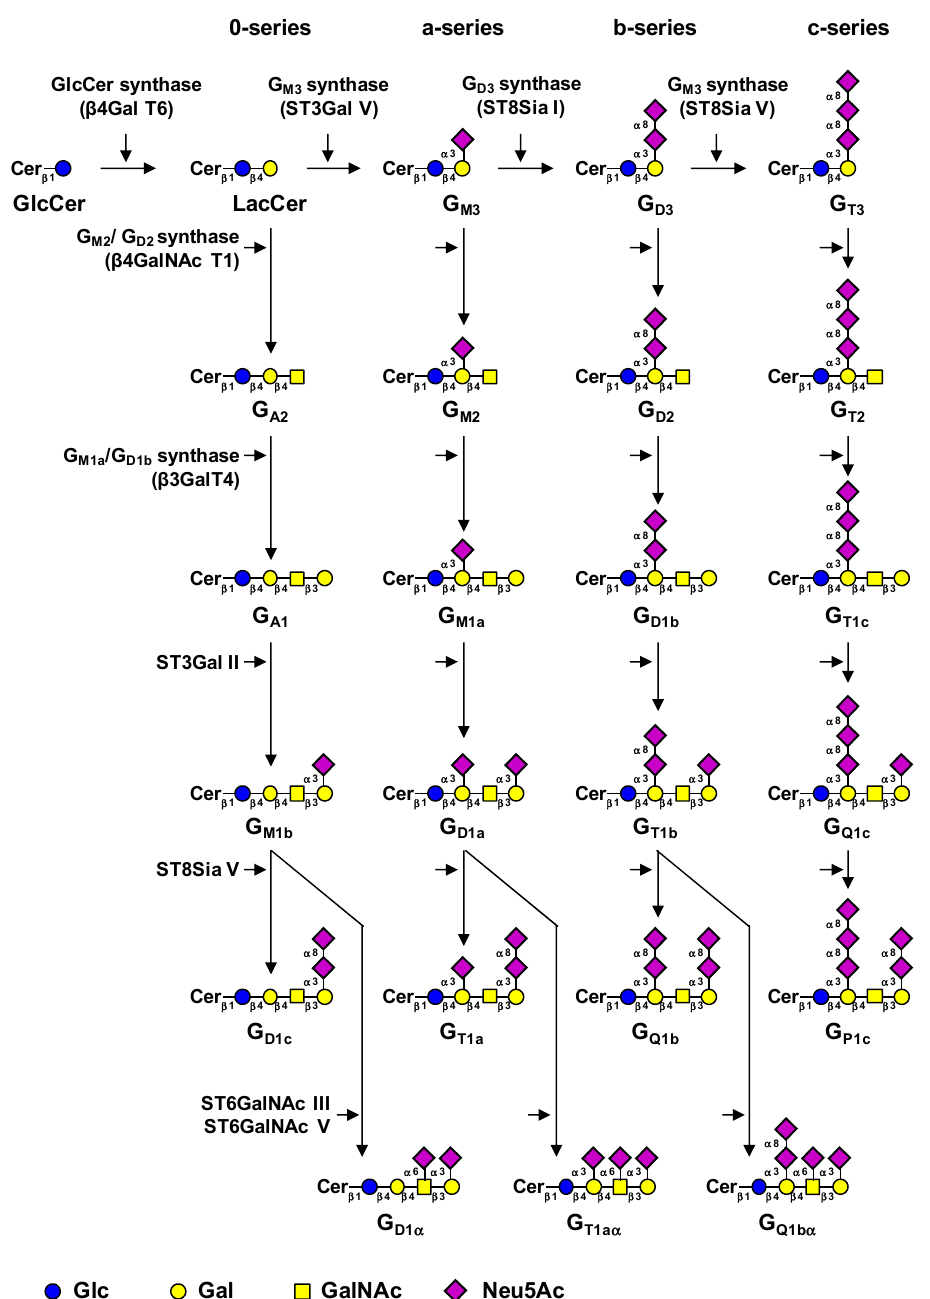
Figure 1. Biosynthesis pathway for gangliosides. Gangliosides are synthesized by the stepwise addition of monosaccharides to ceramide. The sequential action of ST3Gal V (G synthase), ST8Sia I (G synthase), and ST8Sia V (G synthase) leads to the M3 D3 T3 biosythesis of the precursors of a-, b-, and c-series gangliosides, respectively. The 0-series gangliosides are directly synthesized from lactosylceramide. The code names of gangliosides are according to Svennerholm